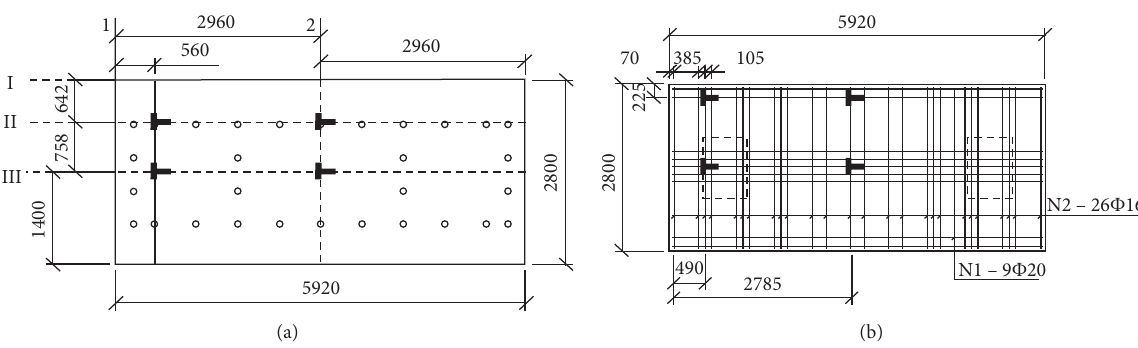
Figure 9: The arrangements of strain gauges (unit: mm): the locations of the (a) concrete strain gauges and (b) steel strain